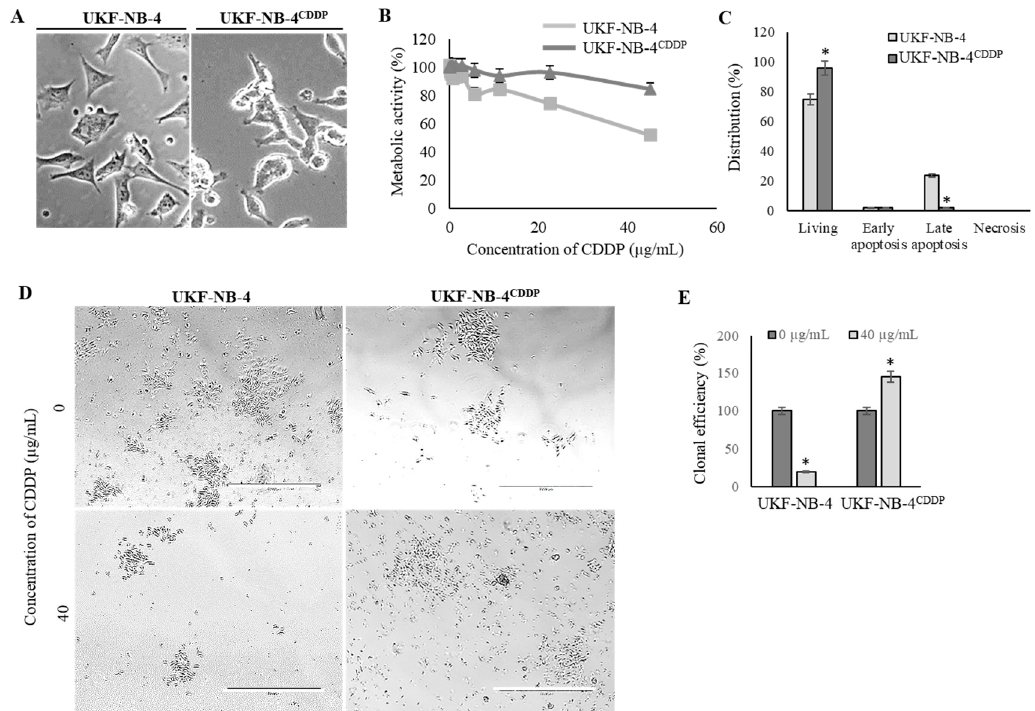
Figure 1. Revalidation of effects of induced cisplatin (CDDP) chemoresistance on phenotypic properties of UKF-NB-4 cells. ( A ) Phase contrast micrographs showing the morphology changes in UKF-NB-4 CDDP cells. Scale bar, 100 µ m. ( B ) MTT dose-response curves of UKF-NB-4 and UKF-NB-4 CDDP cells exposed to CDDP (1–50.0 µ g/mL) for 24 h. ( C ) Distribution of CDDP-induced apoptosis and living cell counts in both tested cell lines evaluated by flow cytometry. The data are results from three independent experiments. * p < 0.01 related to parental cells. ( D ) Detailed representative phase contrast micrographs of clonogenic assay plates showing significant differences in survival and clonal efficiency. The length of scale bar is 1000 µ m. ( E ) Quantitation of clonal efficiency of cells exposed to CDDP. The data are results from three independent experiments. * p < 0.05 related to control non-treated cells.